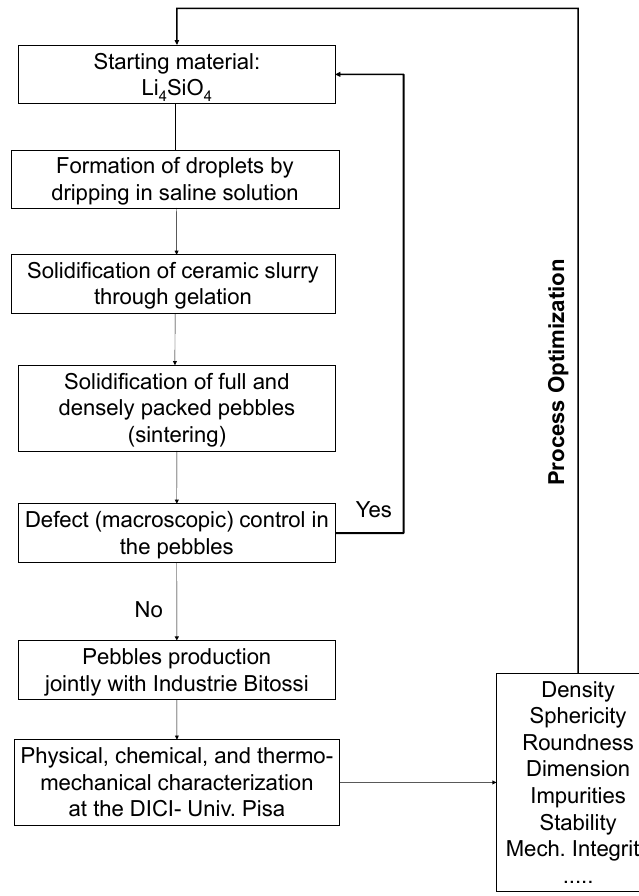
Figure 2. Flow diagram with the main phases of the proposed fabrication process [15].